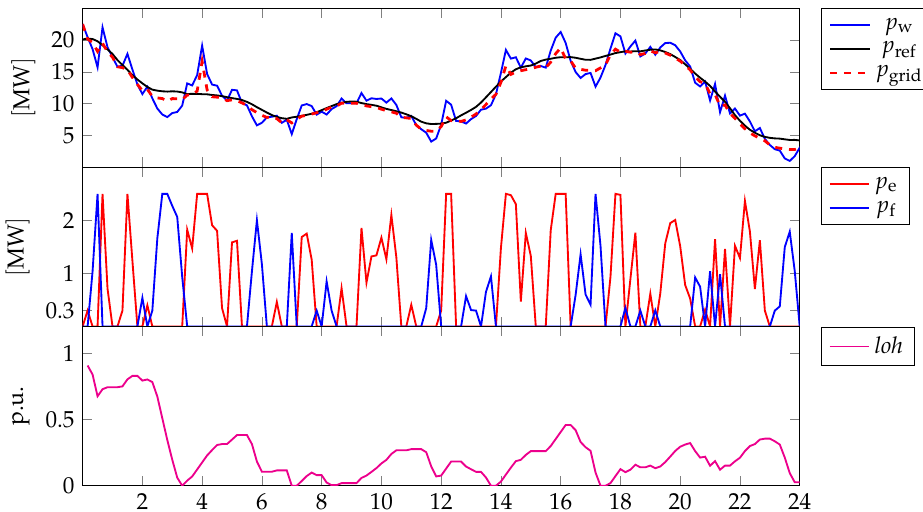
Figure 4. Different profiles related to the reference period from 14:40 of 18 February 2017 to the same hour of 19 February 2017, for highlighting the impact of c . First graph: power by wind generation N (blue line), power reference that has to be delivered to the grid (black line) and actual power delivered (dashed red line); Second graph: power of the electrolyzer (red line) and power of the fuel cell (blue line); Third graph: LoH.